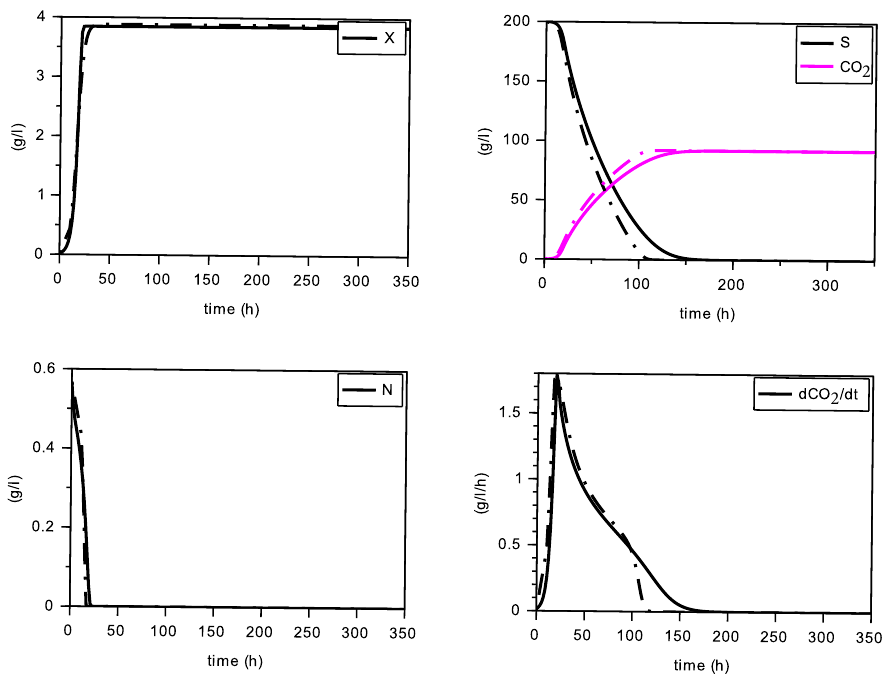
Figure 10. Comparison with the SOFA model (in dashed) for N ( 0 ) = 0.567 g · L − 1 (constant tempera- ture of 24 ◦